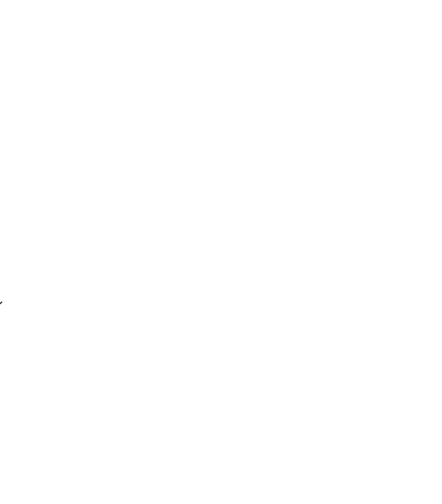
Figure 16. Geometric parameters and polarization directions of the magnet pair for the optimization process.